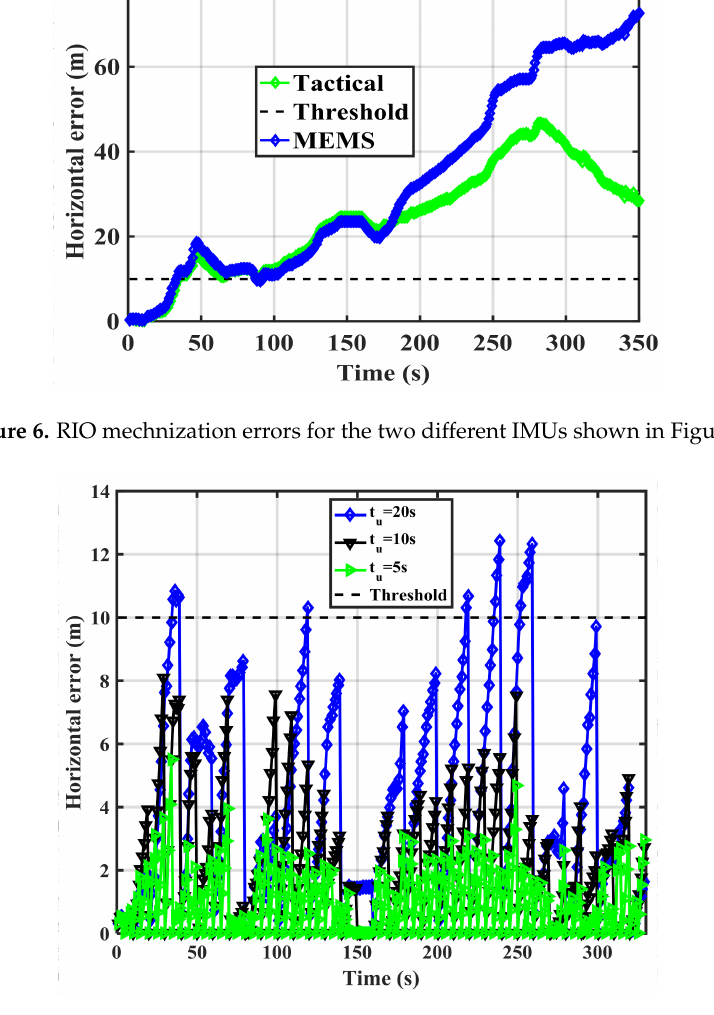
Figure 7. RIO (Cell phone IMU and vehicle odometer) horizontal errors for various update intervals ( t u